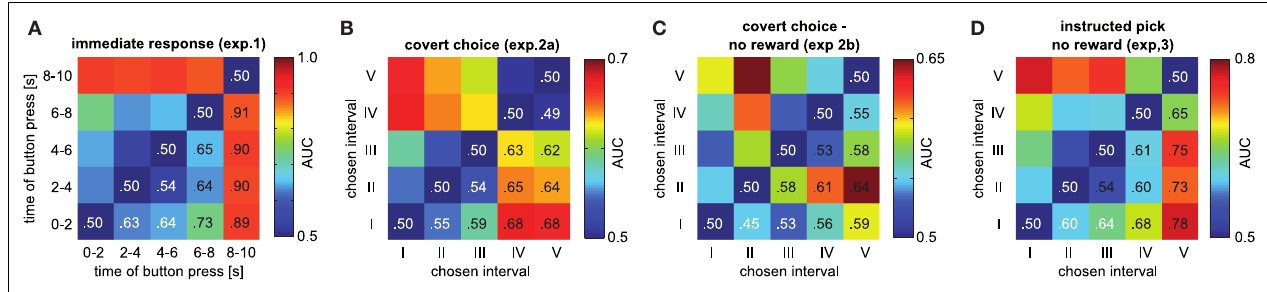
FIGURE 4 | Pairwise discriminability of chosen intervals based on the time of maximum pupil dilation. Values above 50% (chance) consistently indicate that the later chosen interval corresponds to later pupil dilation maxima, yielding a symmetric plot. (A) Experiment 1 (B) Experiment 2. The reduced